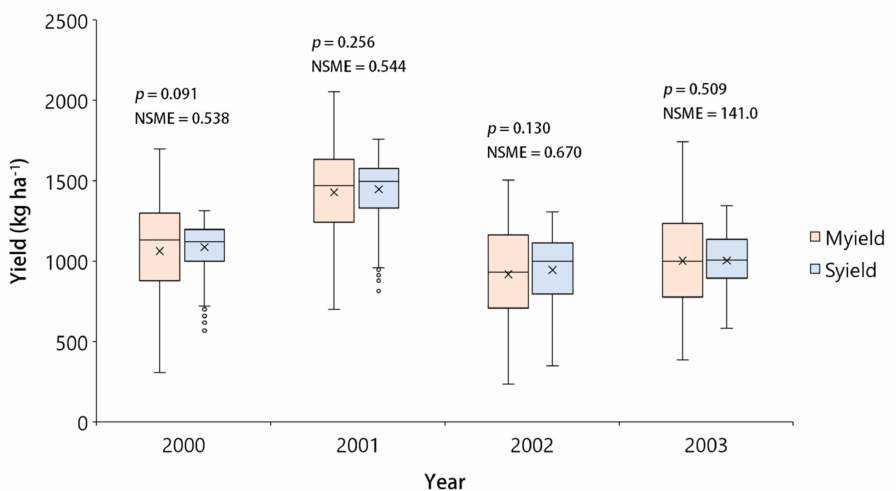
Figure A3. Box and whisker plots and comparison of p values according to the t -test ( α = 0.05) and Nash–Sutcliffe model efficiency (NSME) values for the simulated (S) and measured (M) cotton lint yields of field #28 over time (Figure A2). Error bars and boxes represent the 10th, 25th, 75th, and 90th percentiles of yield data, showing the median (solid line) and mean ( × ) in the box, with circles indicating